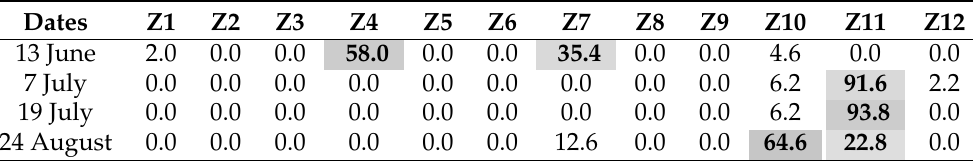
Table 2. Temporal variation in the percentage of data points in each zone for different phenology stages of canola. The zones with high percentages of points at a particular phenology stage are highlighted in